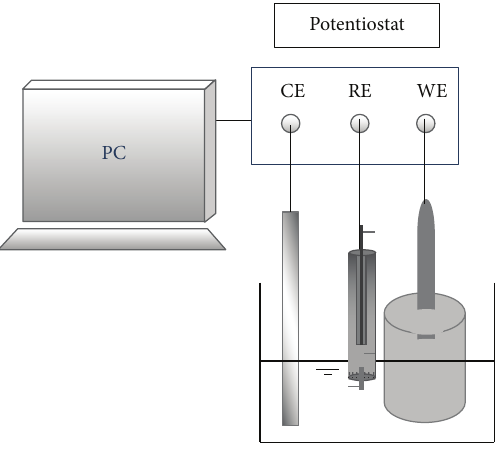
Figure 2: Corrosion current measurement